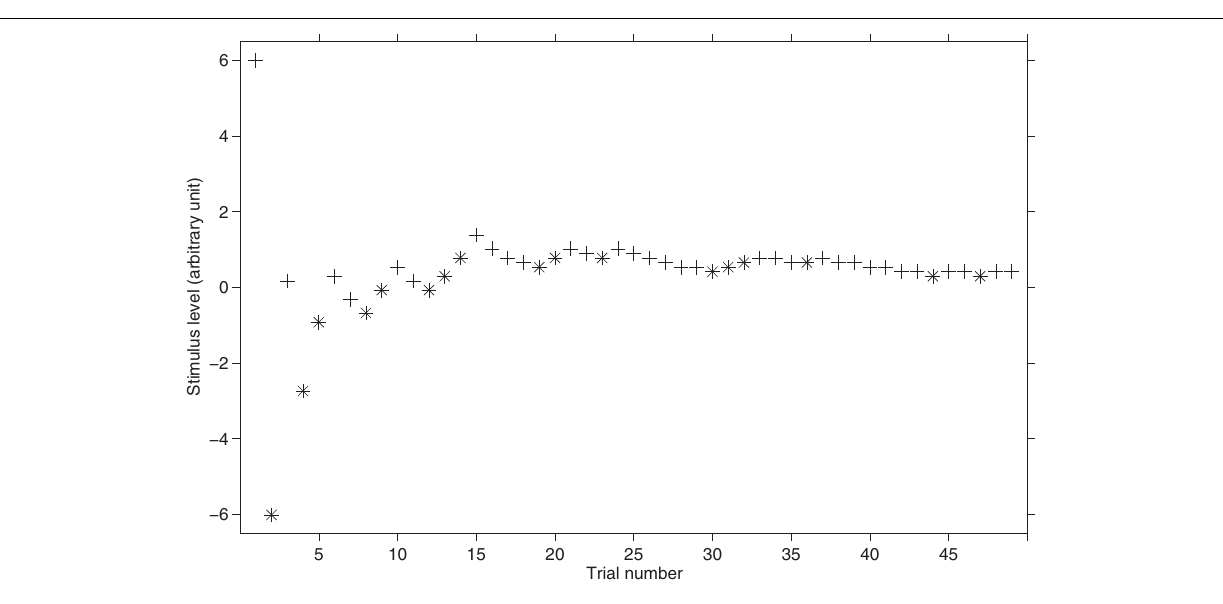
FIGURE 5 | Hypothetical threshold tracking with MLP. The plus sign represents the correct responses whereas the asterisk represents the incorrect responses. The starting stimulus level is 6. Note how in the first trials MLP literally “jumps” between very different stimuli levels.